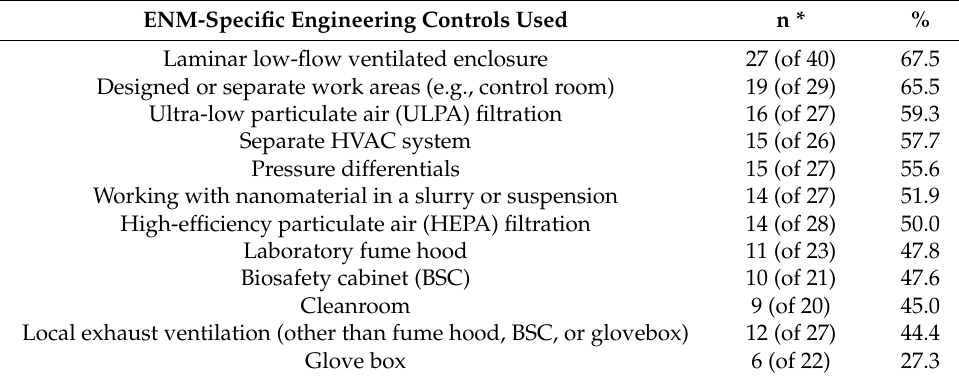
Table 2. ENM-Specific Engineering Controls Used.